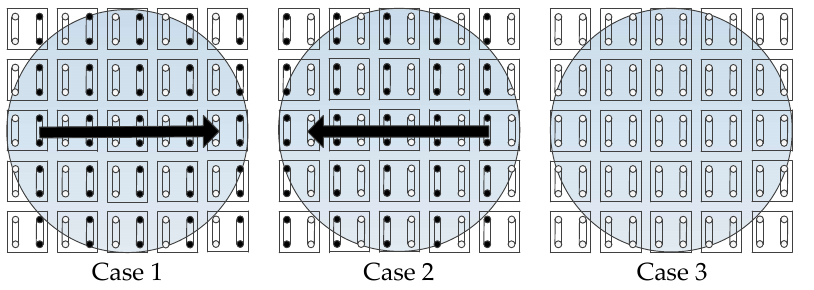
Figure 12. Three cases for the actuating direction.